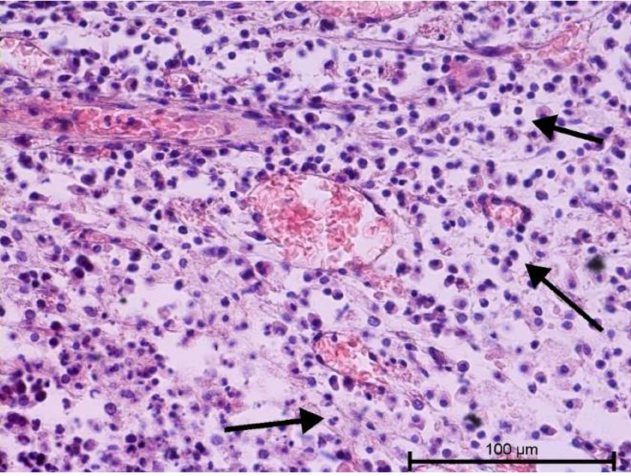
Figure 4. Light microscope image, human molar after extraction—Group IV. Very intense angiogene- sis (arrow). HE stain. Mag. 200 ×